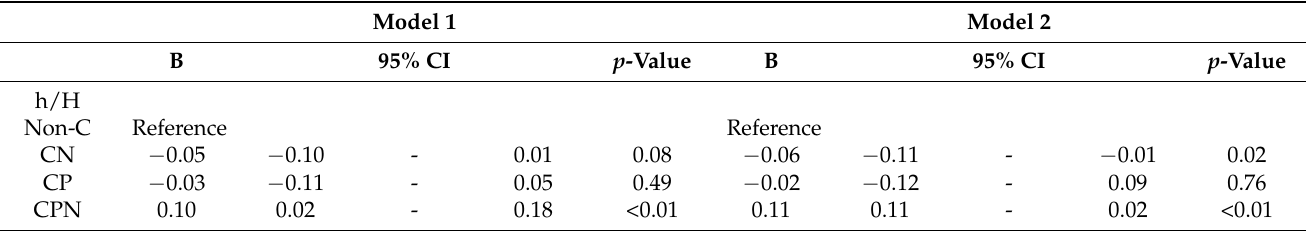
Table 3. Comparison of the changes in the h/H in the different education models during the experiment, with non-C as the reference